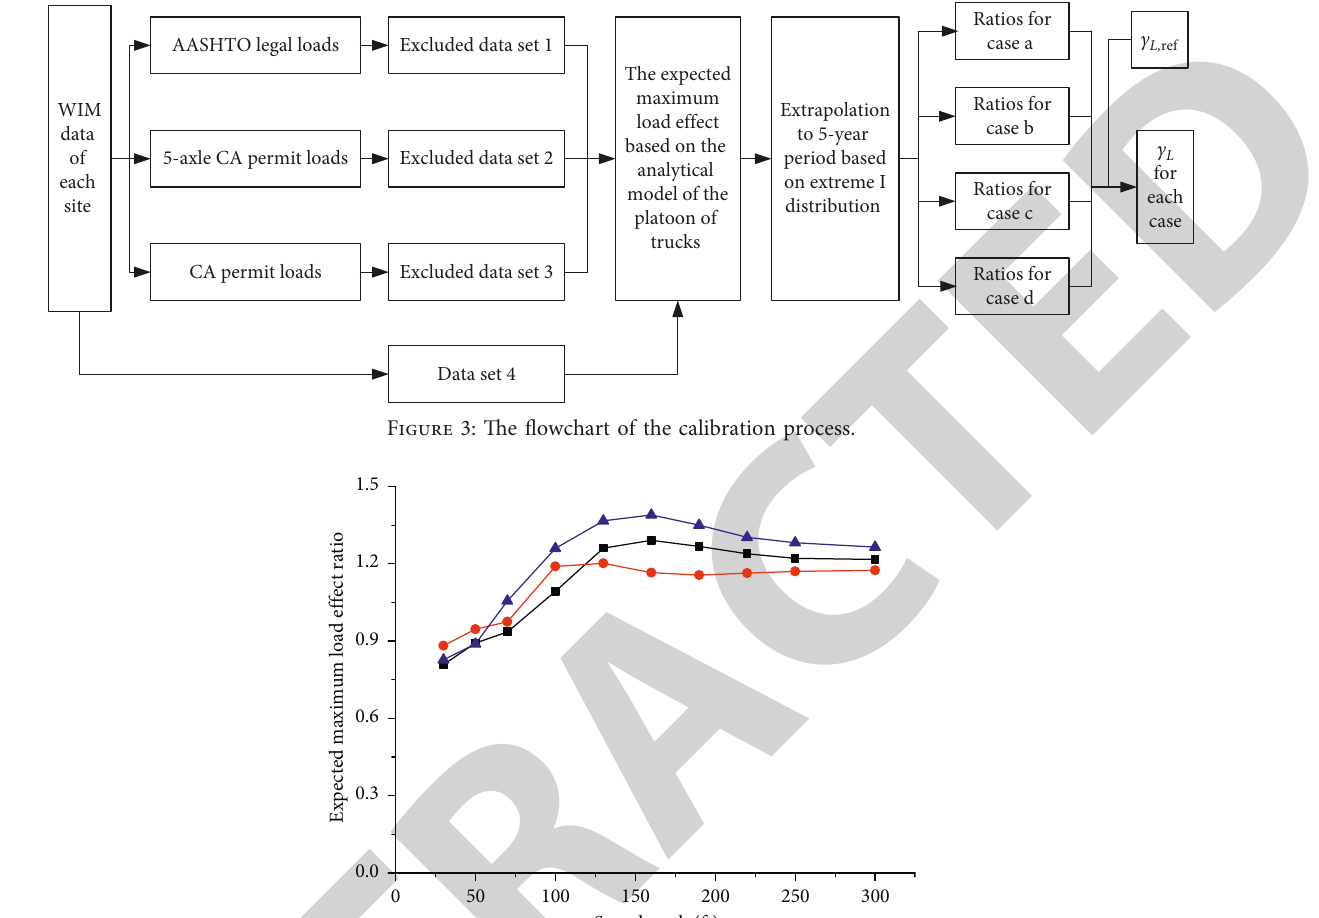
Figure 4: Mean value ratio in equation (8) for site 002 (with 0% allowance).